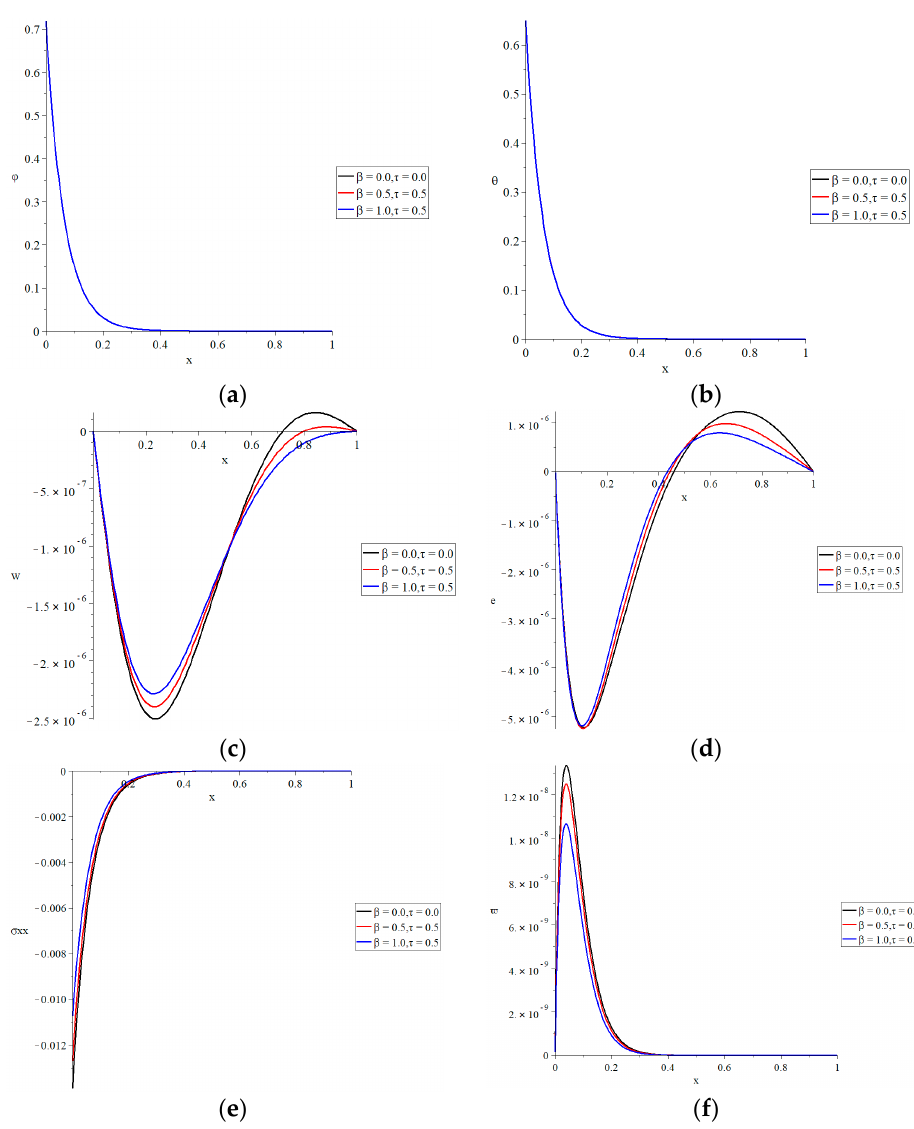
Figure 2. The distributions with variance fractional-order strain parameter when t 0 = 1.0, a = 0.1. ( a ) The distribution of conductive temperature, ( b ) the distribution of dynamic temperature, ( c ) the distribution of lateral deflection, ( d ) the distribution of strain, ( e ) the distribution of deformation stress, and ( f ) the distribution of strain energy density function.